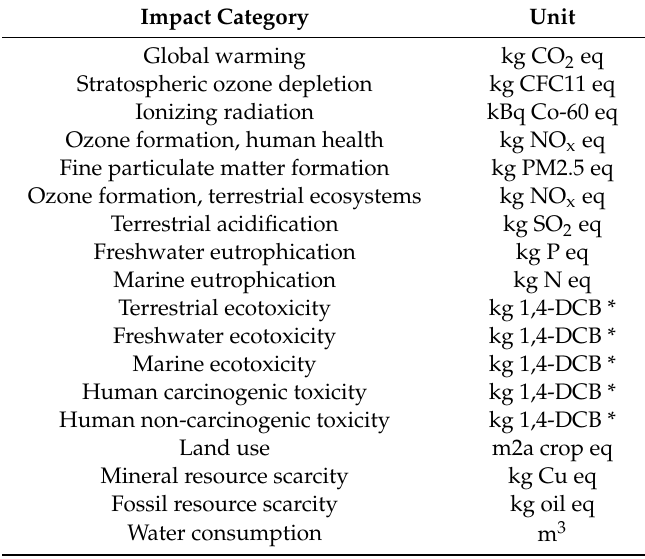
Table 2. Impact categories included in ReCiPe 2016